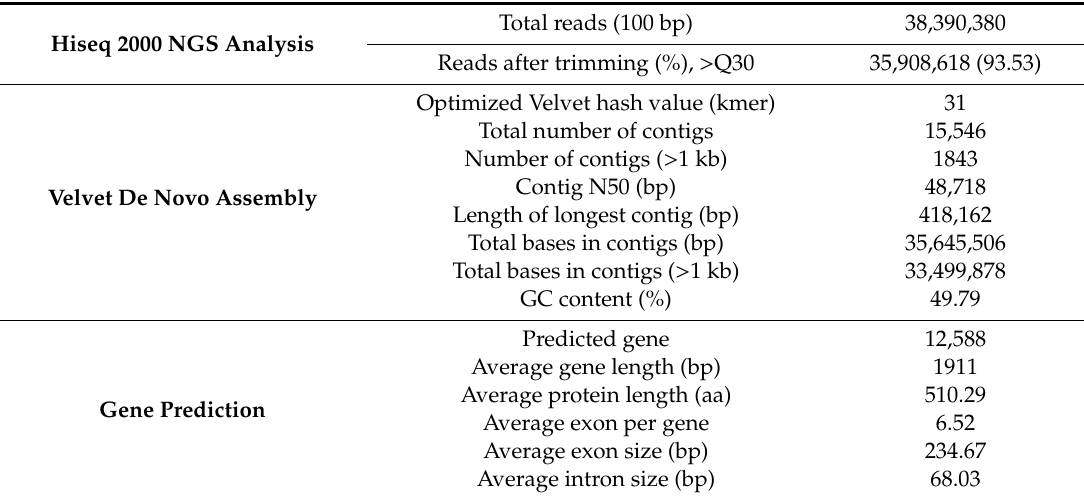
Table 1. Flammulina rossica Genome Sequencing